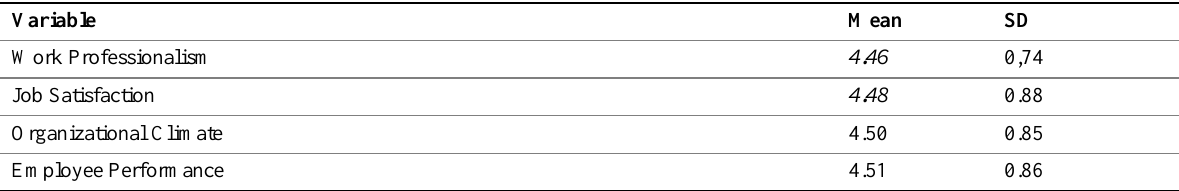
Table 2 : Descriptive Statistic and Correlation